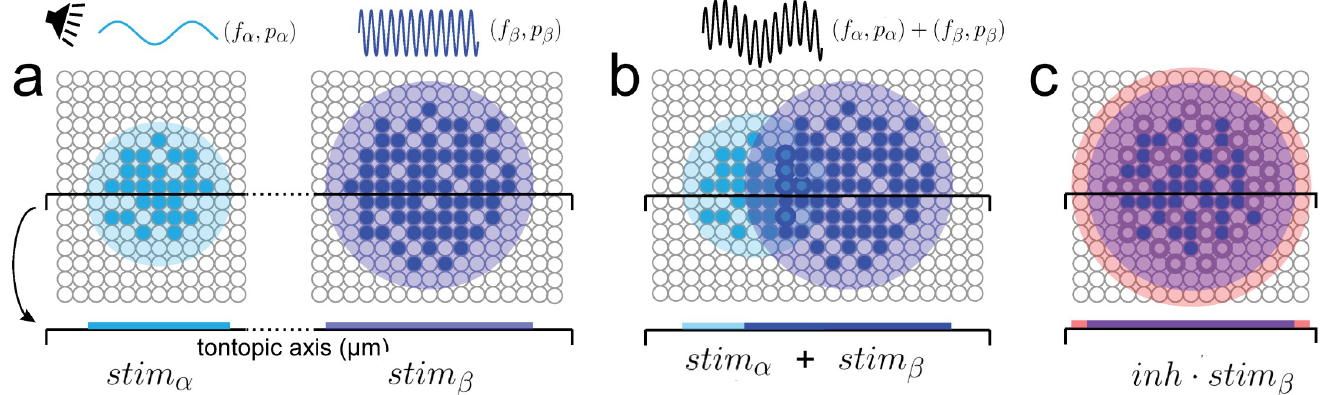
Fig 1. Computations with a place code. a, left , hypothetical neural representation of a low frequency ( f α ), small amplitude ( p α ) pure tone stimulus in a two- dimensional neural network. A stimulus-evoked synaptic field covers a circular area (cyan disk) and causes a subset of cells to fire (filled circles). Projection of the synaptic field onto the tonotopic axis (cyan bar) gives the location and size of the activated area. right , synaptic field generated by a tone with higher frequency ( f β ) and sound pressure ( p β ). b , synaptic field generated by a sound composed of the two tones. c , modulation by inhibition (red).